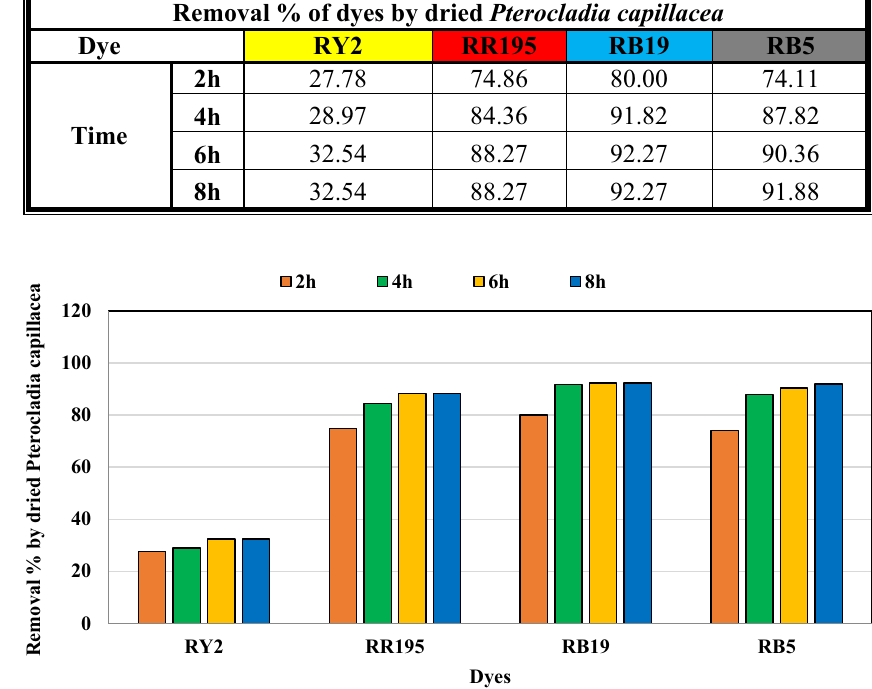
Table 16 Effect of contact time (at optimized conditions) on the removal percentages of the four studied dyes by dried Pterocladia capillacea